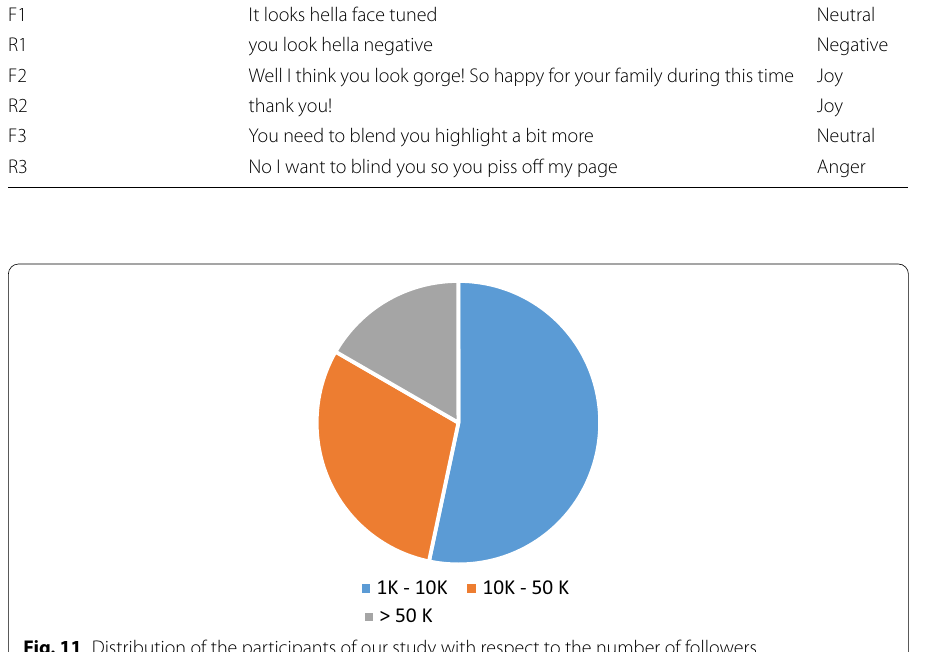
Table 4 Three conversation examples with their sentiments Type